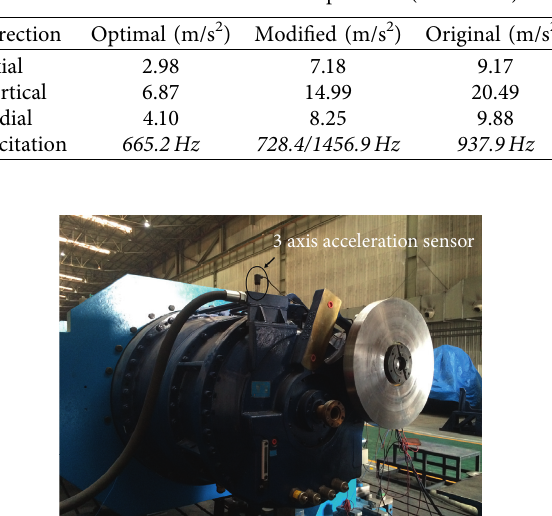
Figure 12: Radial acceleration of the optimal model. Table 13: Simulation results comparisons (all models).